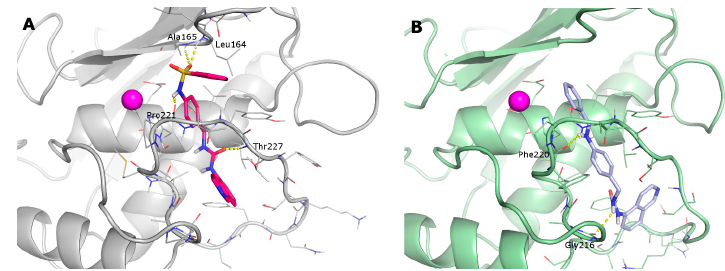
Figure 6. Docking poses of: ( A ) ligand 5 in the MMP-2; ( B ) and ligand 7 in the MMP-13. MMPs are represented as grey (MMP-2), and pale green (MMP-13) cartoons. The zinc ion is a purple sphere; most relevant residues are represented as lines and ligands as sticks. H-bonds are depicted as yellow dashed lined.